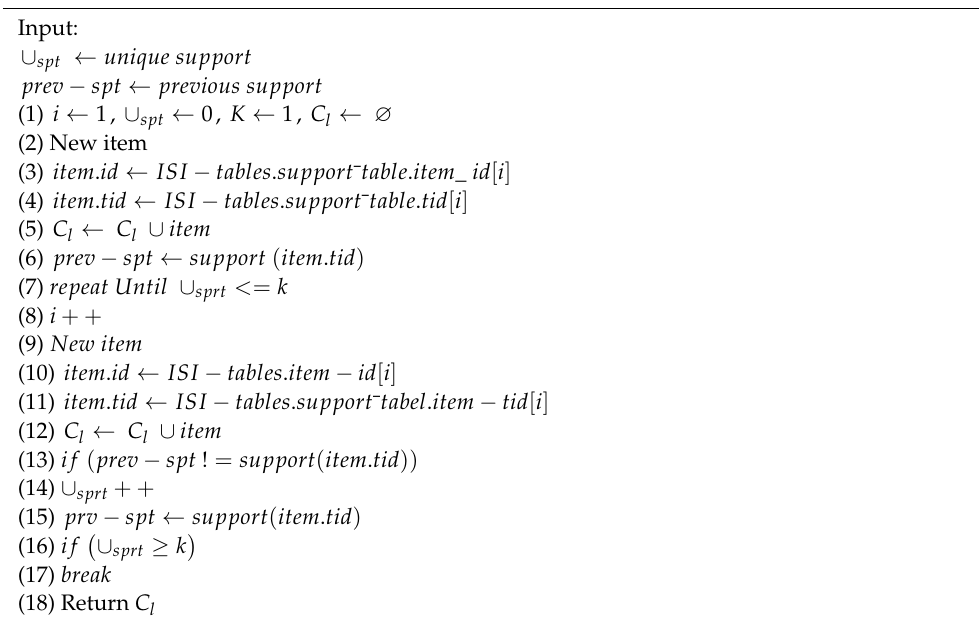
Algorithm 3 select _ K _ item ( ISI - tables , K , C l